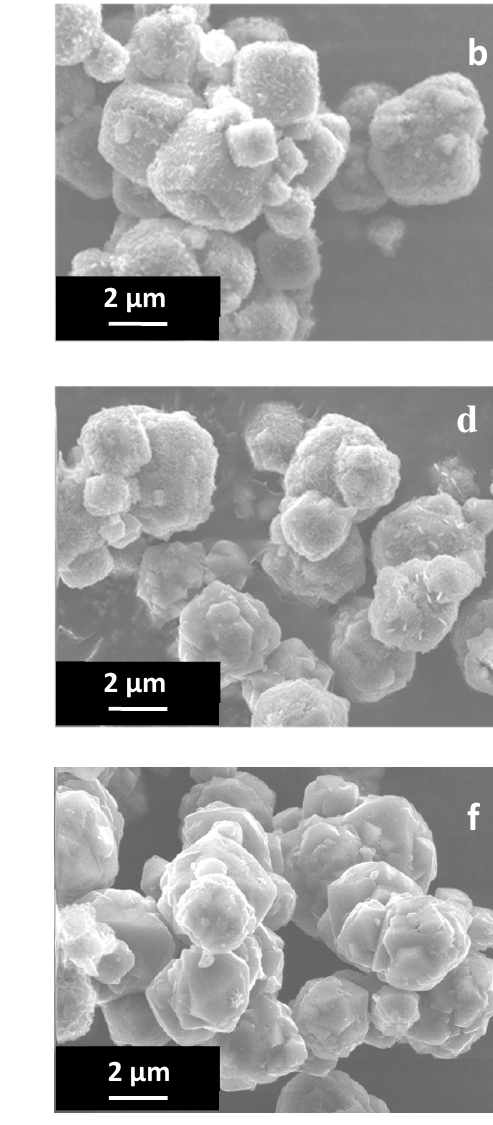
Figure 3. SEM images of ( a ) NaA-0; ( b ) MgA-4; ( c ) NaX-0; ( d ) MgX-4; ( e ) LiA-4 and ( f ) LiX-4 samples.